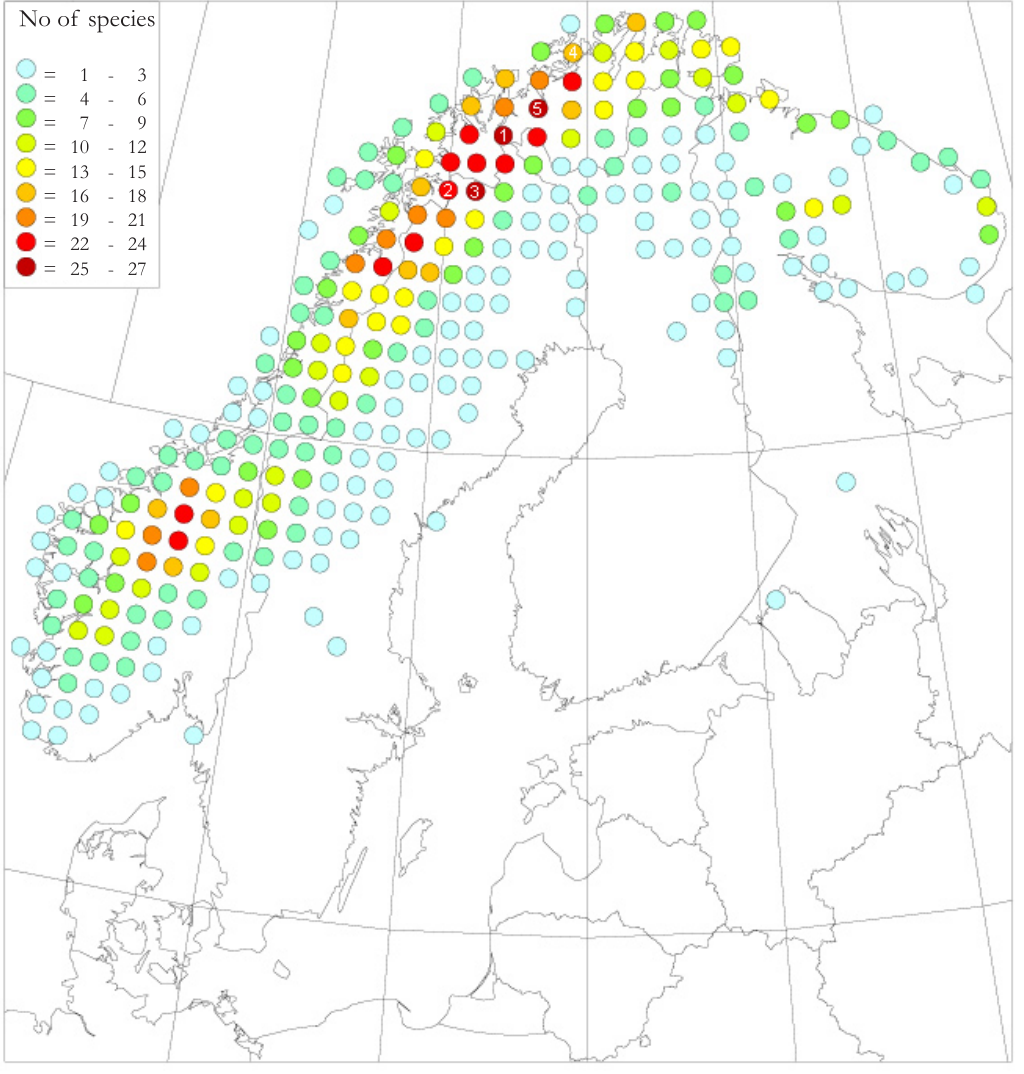
Fig. 1. Occurrence of lime favored arctic-alpine species in different northern grids of Atlas Florae Europaea (Jalas et al . 1972-99). The number on the maps refer to the following sites: 1. Pikku-Malla, Iso-Malla and Saana, 2. Geadgečorro and Boazuvárri, 3. Vággečohkka, 4. Jeahkkir, 5.